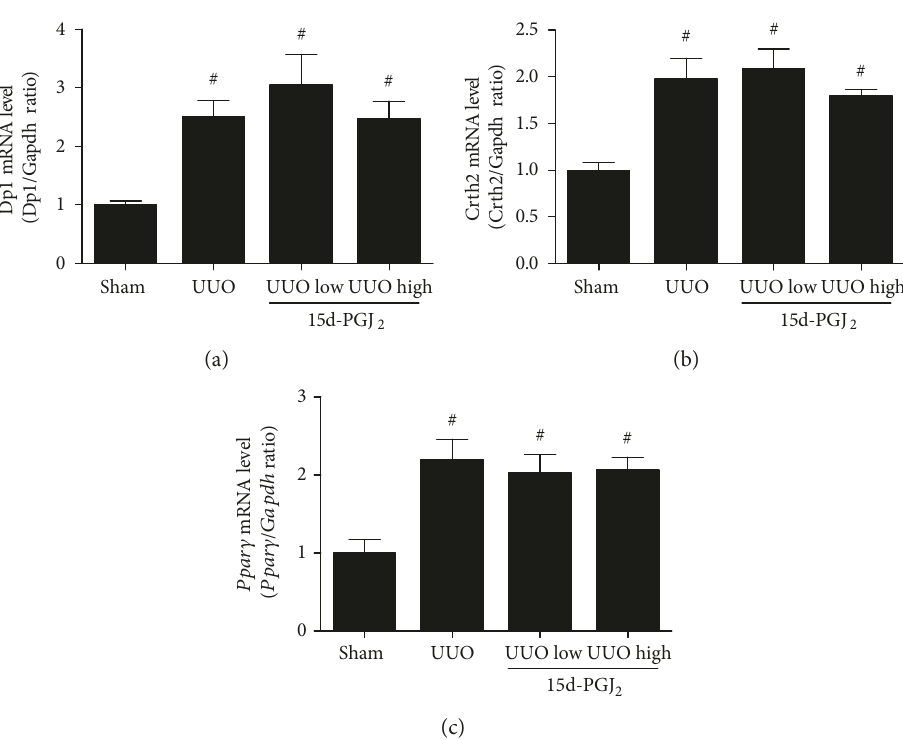
Figure 4: 15d-PGJ receptor expression is increased in response to UUO. mRNA was puri fi ed from kidney cortical tissue and analyzed using 2 qPCR. (a) Dp1 mRNA levels in response to UUO. (b) Crth2 mRNA levels in response to UUO. (c) Ppar γ mRNA levels in response to UUO. 15d-PGJ was administered at a low (0.5 mg/kg/day) and a high (1 mg/kg/day) dose as depicted in each graph. Data represents mean ± SEM. 2 # P < 0 05 versus that in sham, using ANOVA and Bonferroni ’ s post hoc tests ( n = 5 , sham; n = 6 , 3-day UUO groups). UUO, unilateral ureteral obstruction. Table 2: E ff ect of 15d-PGJ2 on body weight, kidney weight, and functional plasma parameters. Sham UUO UUO +low 15d-PGJ Body weight, g